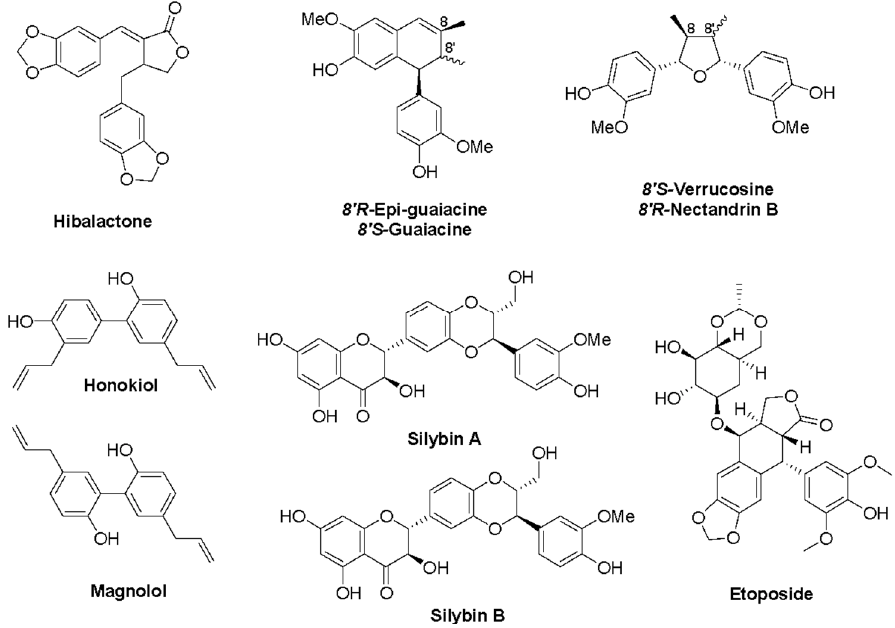
Figure 1. The structures of the lignans hibalactone, epi -guaiacin, guaiacin, verrucosin, nectandrin B, honokiol and magnolol, the glycoside etoposide, and the flavonolignan